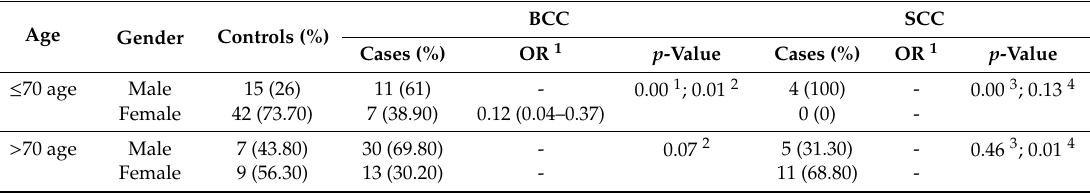
Table 3. Age and gender stratification and skin cancer risk.